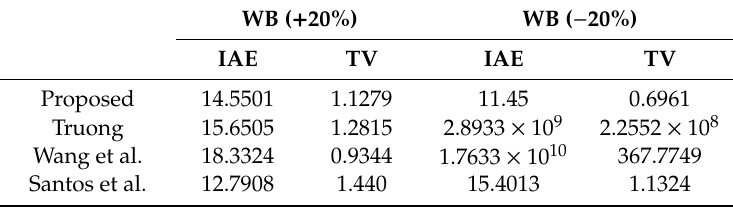
Table 6. Robustness analysis for the WB column under ± 20% parametric uncertainty in all parameters.